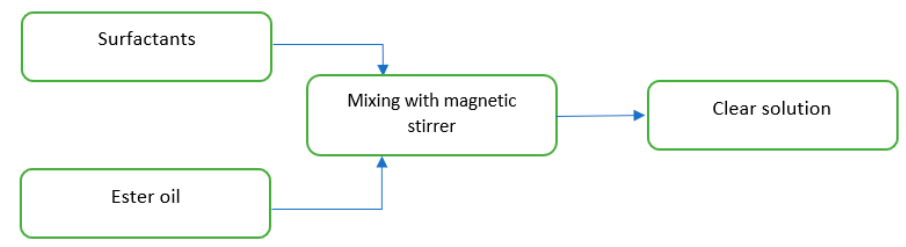
Figure 3. Method of making tested solutions.